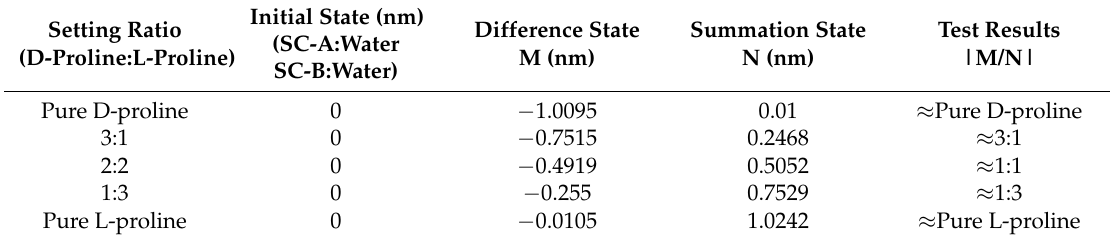
Figure 5. The figure shows the relative shifts in the central wavelengths of the different ratios of L-proline and D-proline in the two states of summation and difference. Table 1. Comparison of settings and test results.